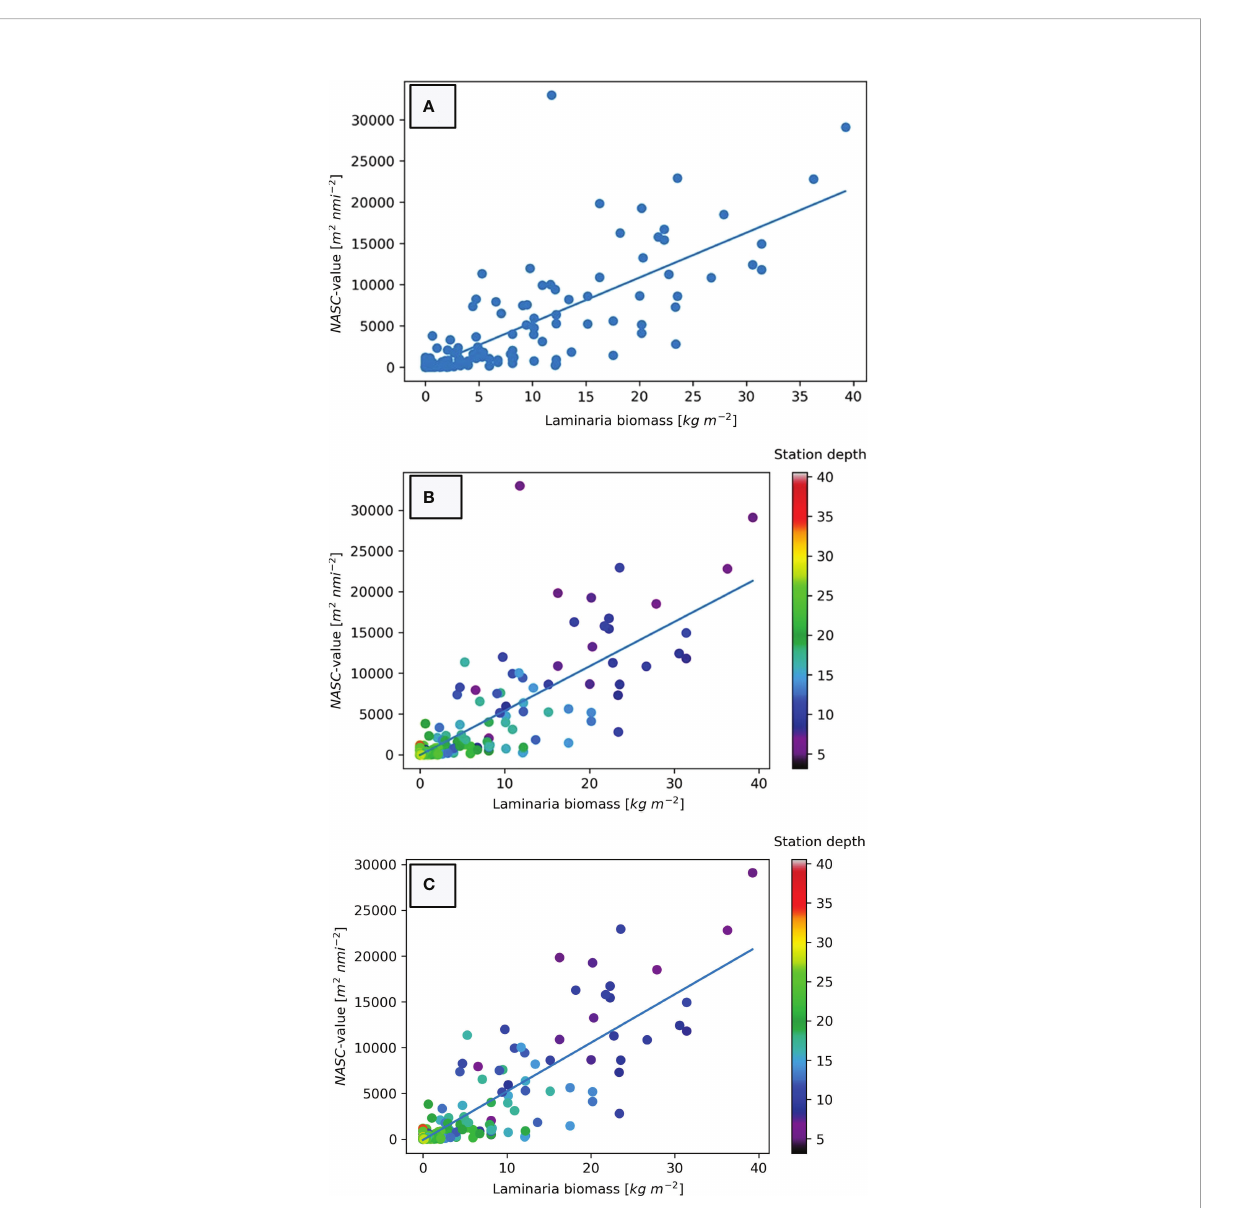
FIGURE 7 (A) Estimated biomass of kelp for each station (x-axis) plotted against NASC-value derived from echograms of the same stations (y-axis). A linear regression model has been established using least squares fi t. (B) Cross-plot of estimated biomass and NASC-values from echograms with station depth indicated by a colour scale. Note the high density of points in the lower left corner of the fi gure. (C) Cross-plot of estimated biomass and NASC-values with colour coded depth scale where Helgeland station 113 has been removed from the dataset due to incompatibility between video and acoustic